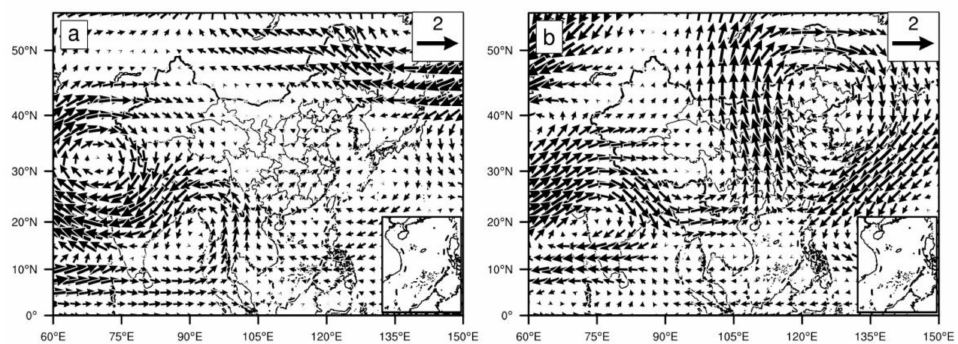
Figure 5. ( a ) Regressed anomalies of the interannual component of 700 hPa wind (vector, unit: ms − 1 ) onto the interannual components of the PC1 for the period of 1960 to 2018. ( b ) As in ( a ), but for PC2. The bold arrows denote the U or V components of wind anomalies have passed the 95% confidence